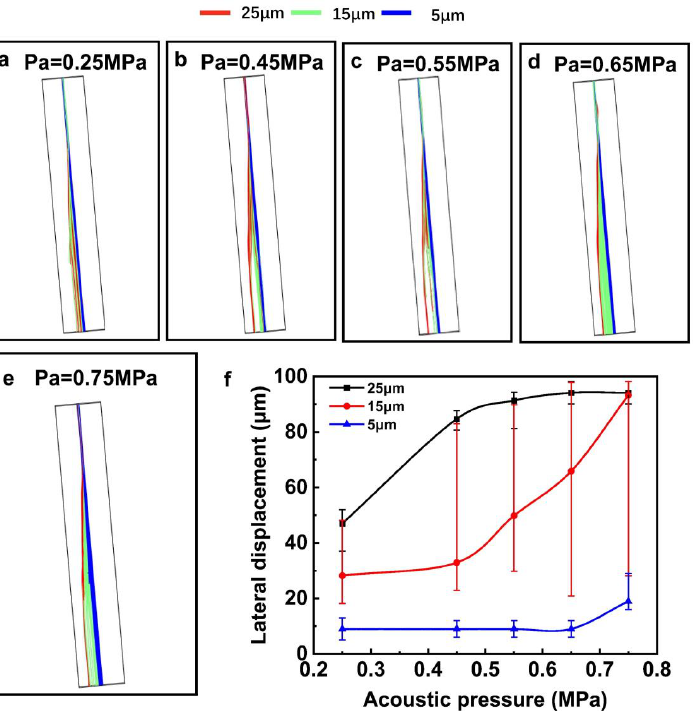
Figure 7. The particle trajectories under different acoustic pressures ( a – e ), the summary of the separation distance at different acoustic pressures ( f ).